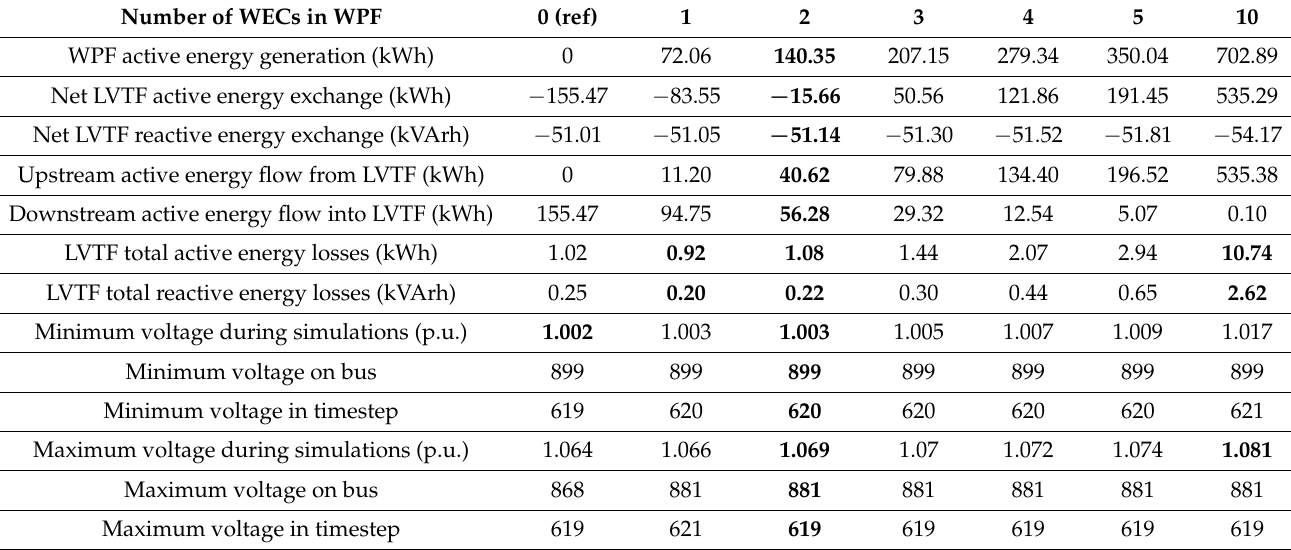
Table 5. Results of the daily operation simulation for case study 1–optimal number of WECs in a WPF for the winter season (consumption). LVTF: Low Voltage Test Feeder.